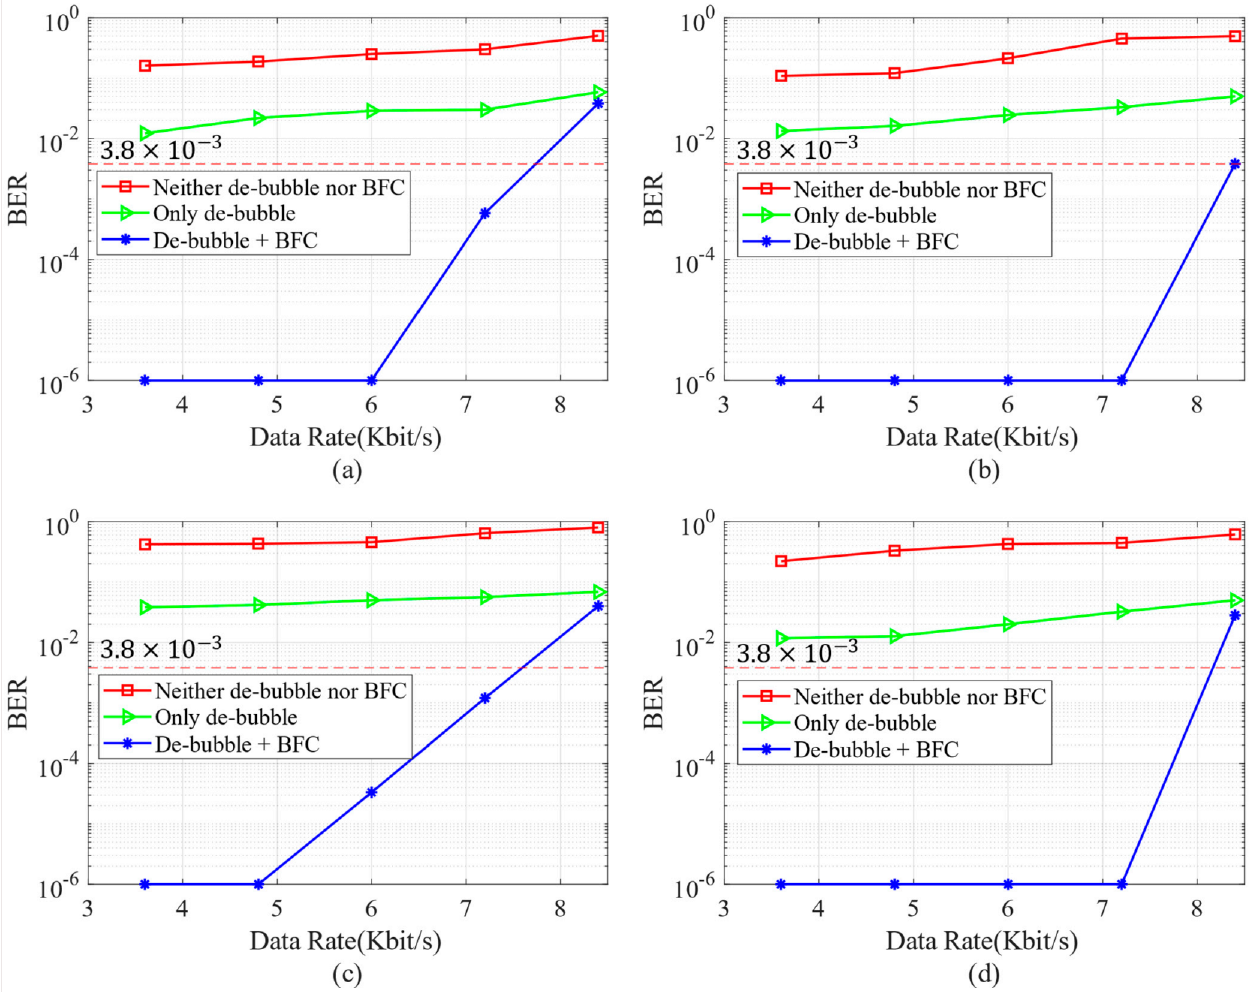
Figure 12. Bit error rate (BER) performance between of the proposed methods with ( a ) dense bubbles ( K = 10 cm); ( b ) sparse bubble degradation ( K = 10 cm); ( c ) dense bubble degradation ( K = 5 cm), and ( d ) sparse bubbles ( K = 5 cm). Table 3. BER under different bubble environments in tap water and saline